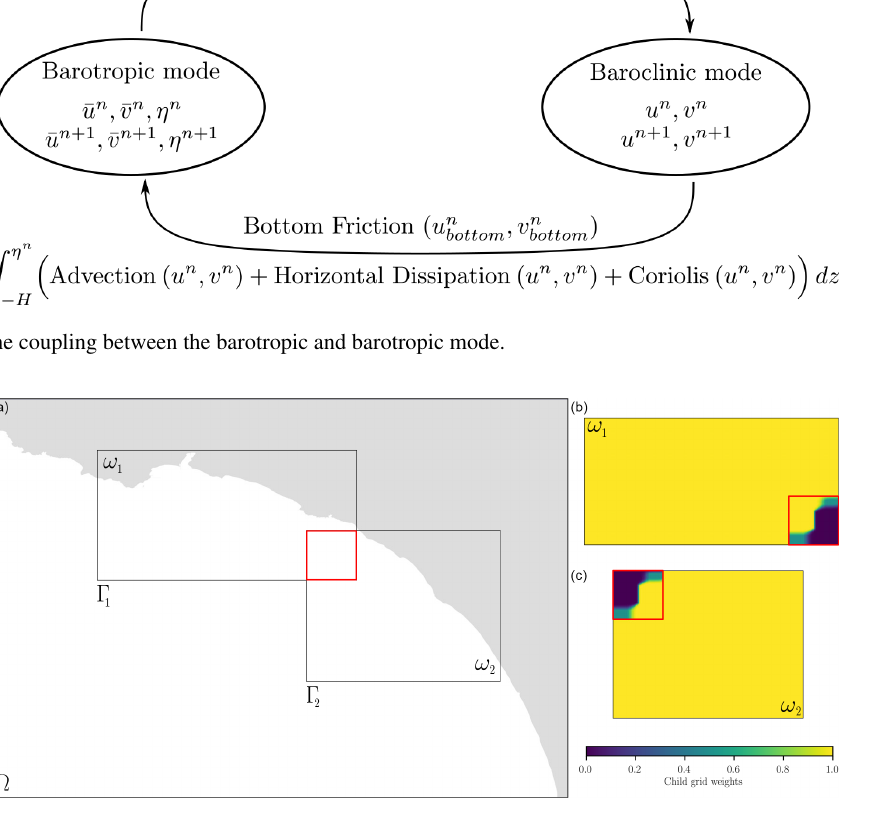
Figure 3. (a) Local refinement with two child grids. (b) The weights used for interactions at the same hierarchical level on the overlapping area are represented with a red